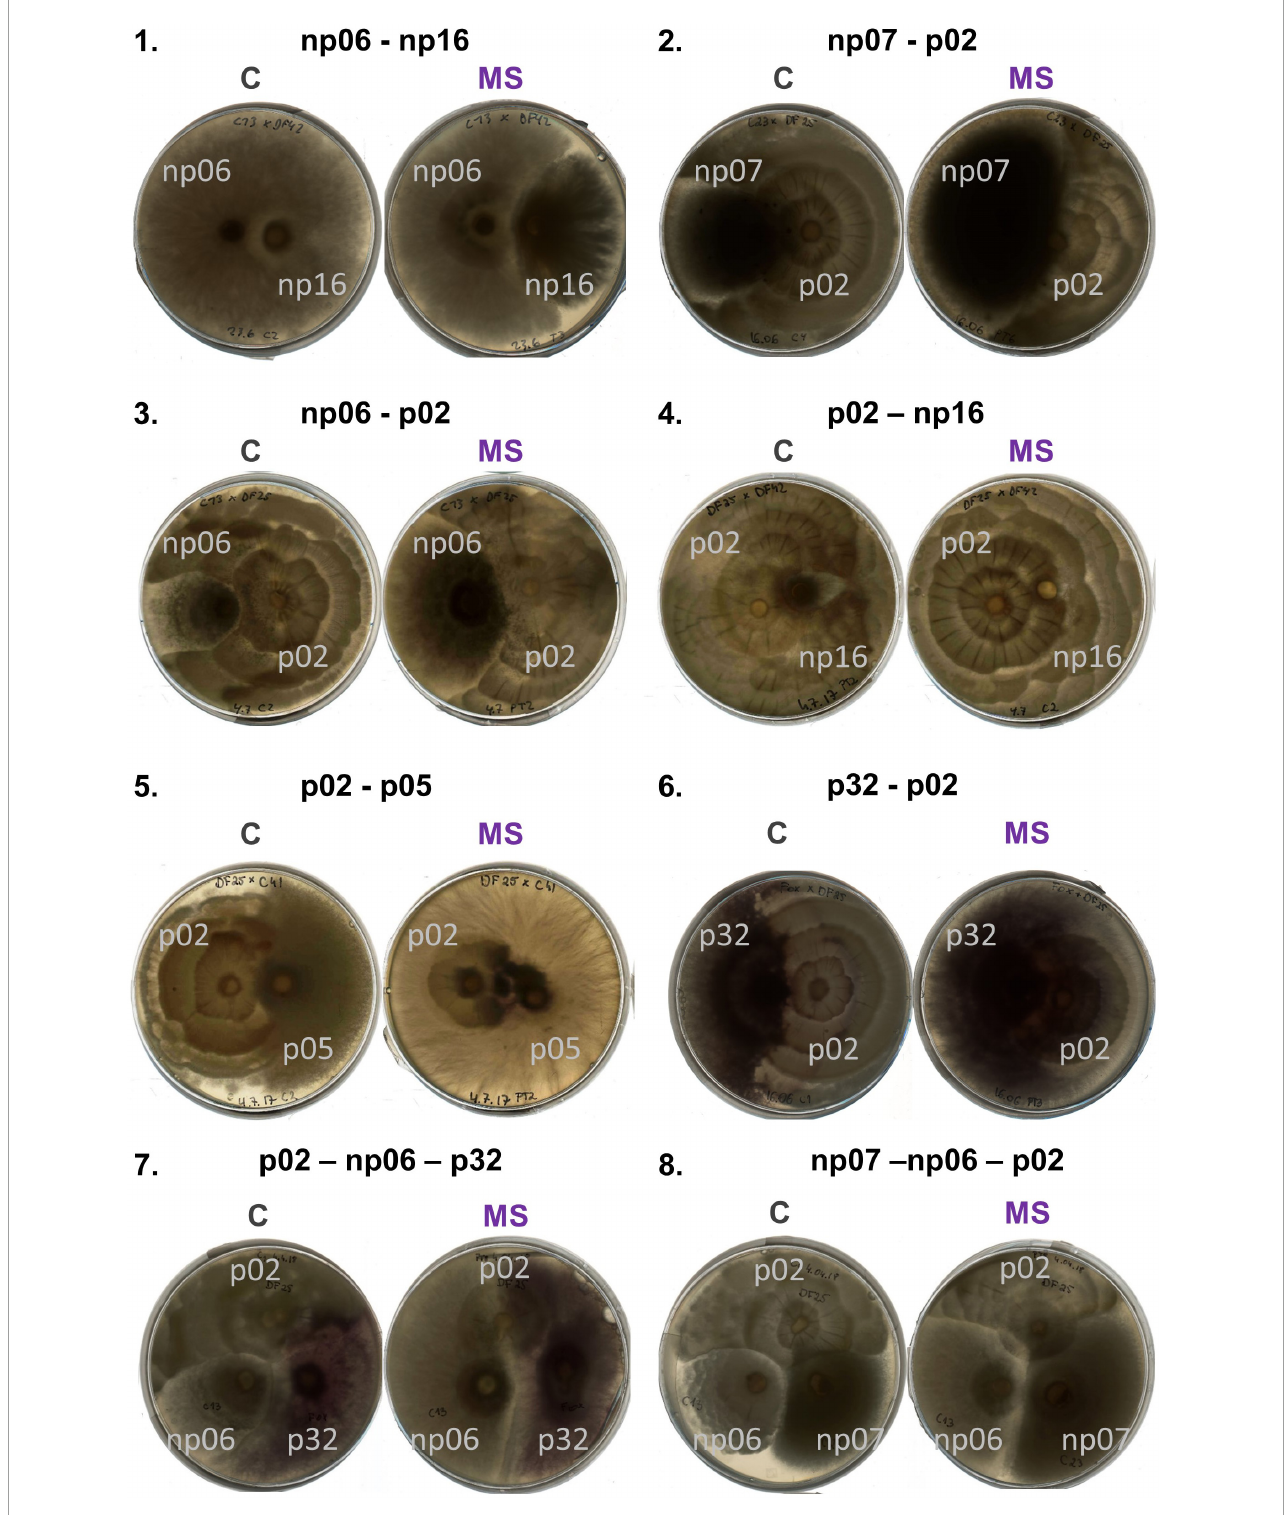
FIGURE3 Panel with pictures of plates of isolates discussed in the text grown in pairs (1–6) and triplets (7,8) according to the treatments control (C) and mild strong (MS).